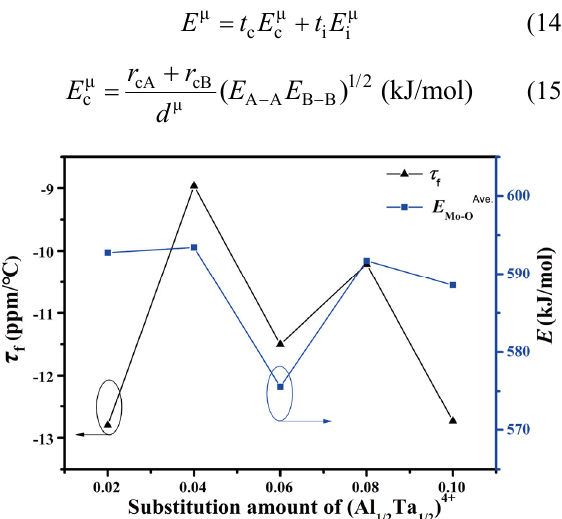
Fig. 13 τ f and the Mo  O bond energy of CZMAT ceramics as a function of the value of